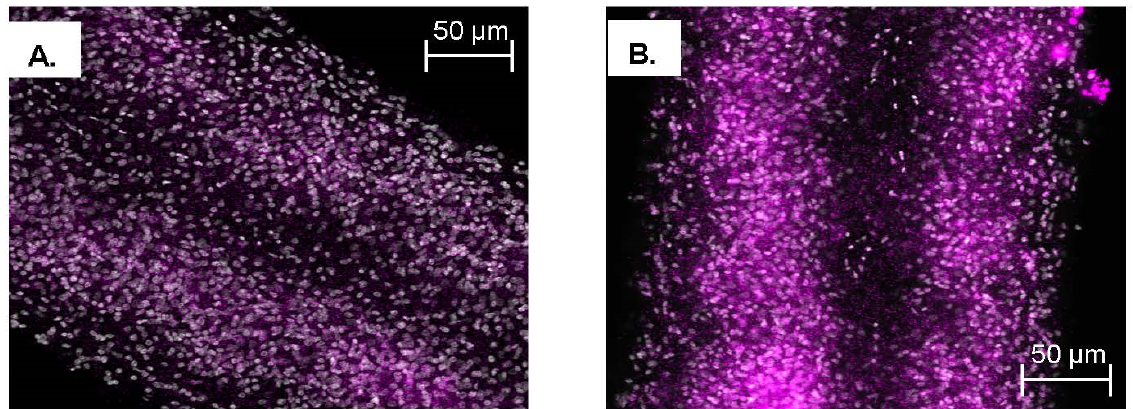
Figure 11. Fluorescence in situ hybridization of ShSULT . Midsection of S. haematobium male. Cells positive for ShSULT stained positive for TAMRA-Tyramide, magenta. ShSULT -specific probe was used at a concentration of 100 ng/mL DAPI was not included. FISH was performed on whole worms. ( A ) Z-stack image. ( B ) Whole section. These photos are representative of photos from four worms.